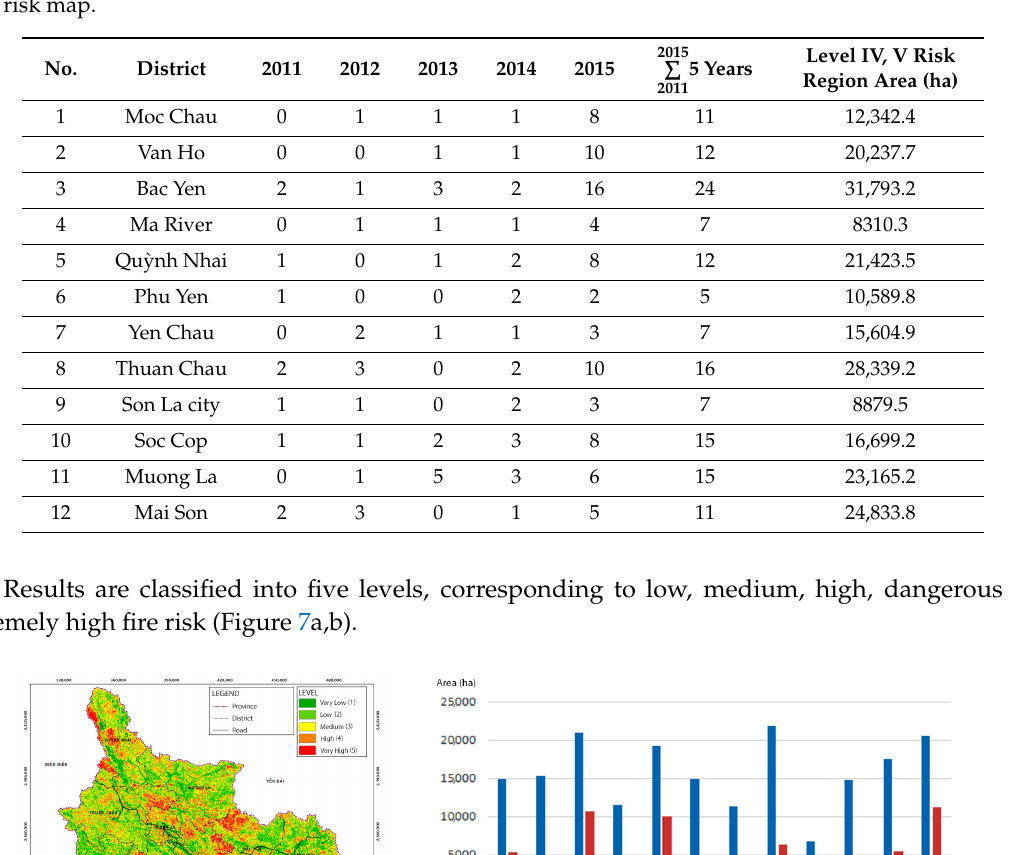
Table 4. Comparison of the forest fires between 2011 and 2015 in Son La Province and the forest fire risk map.